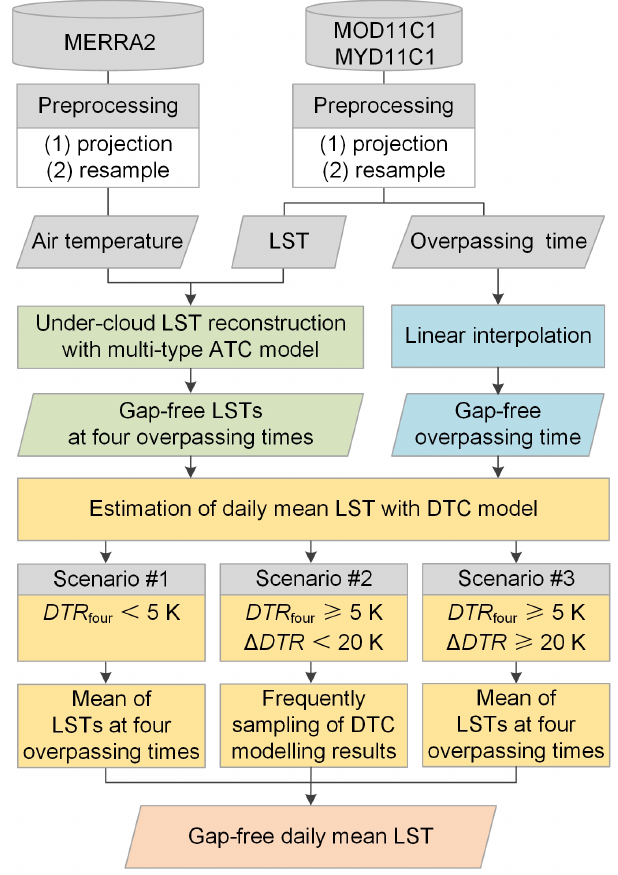
Figure 2. Flowchart of the IADTC framework. DTR four refers to diurnal temperature range (DTR) calculated as the maximum minus the minimum from the gap-free LSTs at the four overpass times; DTR DTC refers to the DTR calculated from the hourly LSTs mod- eled with the DTC model. (cid:49) DTR refers to the absolute difference between DTR four and DTR DTC